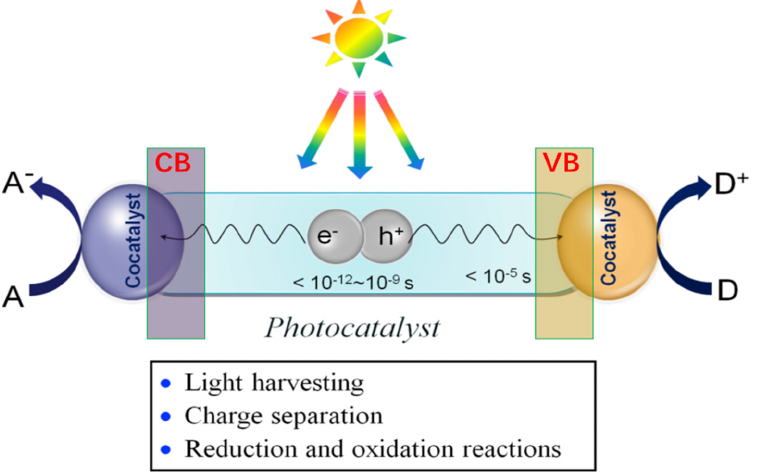
Figure 2. Proposed mechanism for a photocatalytic reaction on a semiconductor photocatalyst. Reprinted/adapted with permission from Ref. [42]. 2014, ACS publications